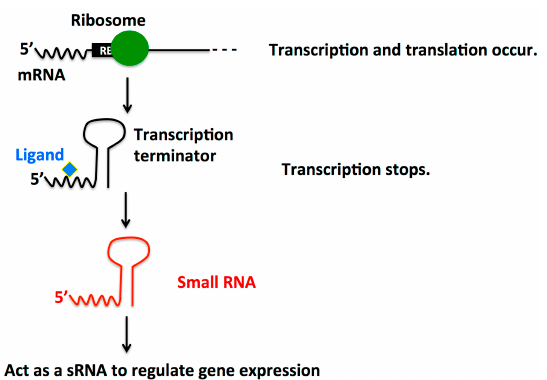
Figure 4. Dual function Riboswitch/sRNA. Riboswitches are regulatory segments of mRNA that can bind a small molecule ligand to induce a structural change. After binding to a ligand, these regulatory segments can form a transcription terminator loop to stop transcription and either be degraded or in some cases, can be utilized as an sRNA. The sRNA then regulates gene expression.